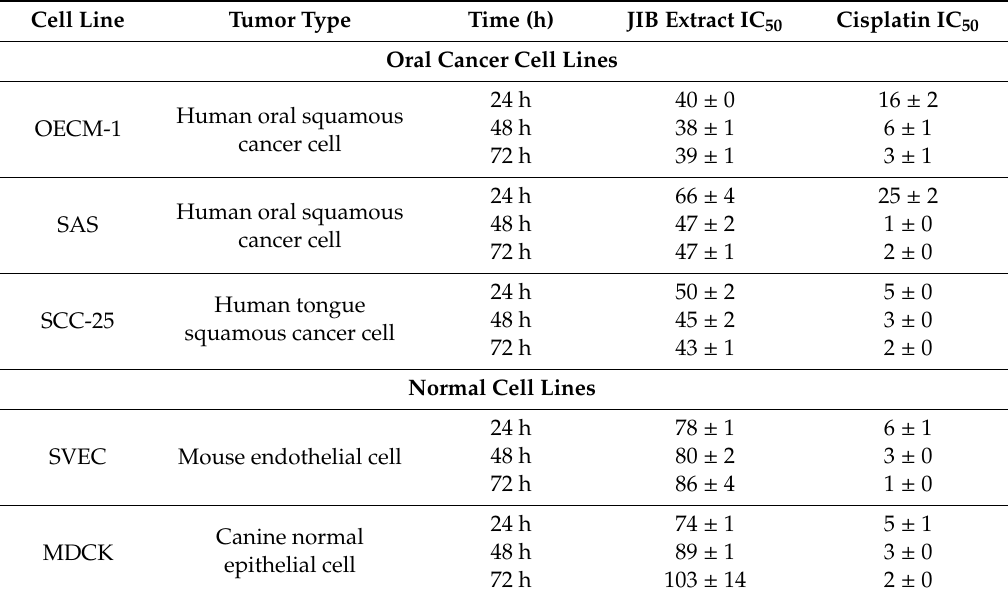
Table 1. IC 50 values of JIB extract and cisplatin in di ff erent oral cancer and normal cell lines. Cell Line Tumor Type Time (h) JIB Extract IC 50 Cisplatin IC 50 Oral Cancer Cell Lines 24 h 40 ± 0 16 ± 2 Human oral squamous 48 h 38 ± 1 6 ± 1 OECM-1 cancer cell 72 h 39 ± 1 3 ± 1 24 h 66 ± 4 25 ± 2 Human oral squamous 48 h 47 ± 2 1 ± 0 SAS cancer cell 72 h 47 ± 1 2 ± 0 24 h 50 ± 2 5 ± 0 Human tongue 48 h 45 ± 2 3 ± 0 SCC-25 squamous cancer cell 72 h 43 ± 1 2 ± 0 Normal Cell Lines 24 h 78 ± 1 6 ± 1 48 h 80 ± 2 3 ± 0 SVEC Mouse endothelial cell 72 h 86 ± 4 1 ± 0 24 h 74 ± 1 5 ± 1 Canine normal 48 h 89 ± 1 3 ± 0 MDCK epithelial cell 72 h 103 ± 14 2 ±